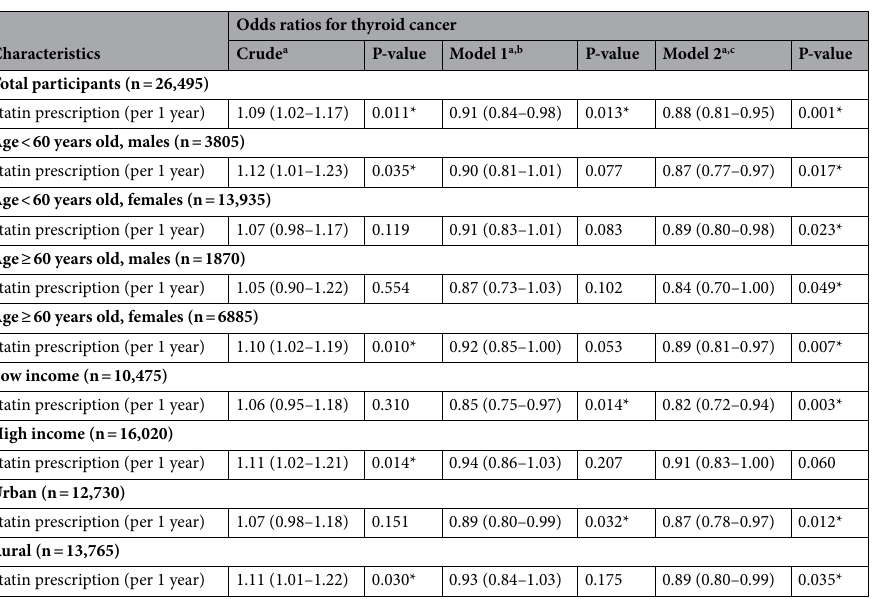
Table 4. Odds ratios (95% confidence interval) of the date of lipophilic statin prescription (per 1 year) for thyroid cancer with subgroup analyses according to age, sex, income, and region of residence. CCI, Charlson comorbidity index; DBP, diastolic blood pressure; SBP, systolic blood pressure. *Conditional logistic regression, Significance at P < 0.05. a Models were stratified by age, sex, income, and region of residence. b A model 1 was adjusted for dyslipidemia history, total cholesterol, SBP, DBP, and fasting blood glucose. c A model 2 was adjusted for model 1 plus obesity, smoking, alcohol consumption, and CCI